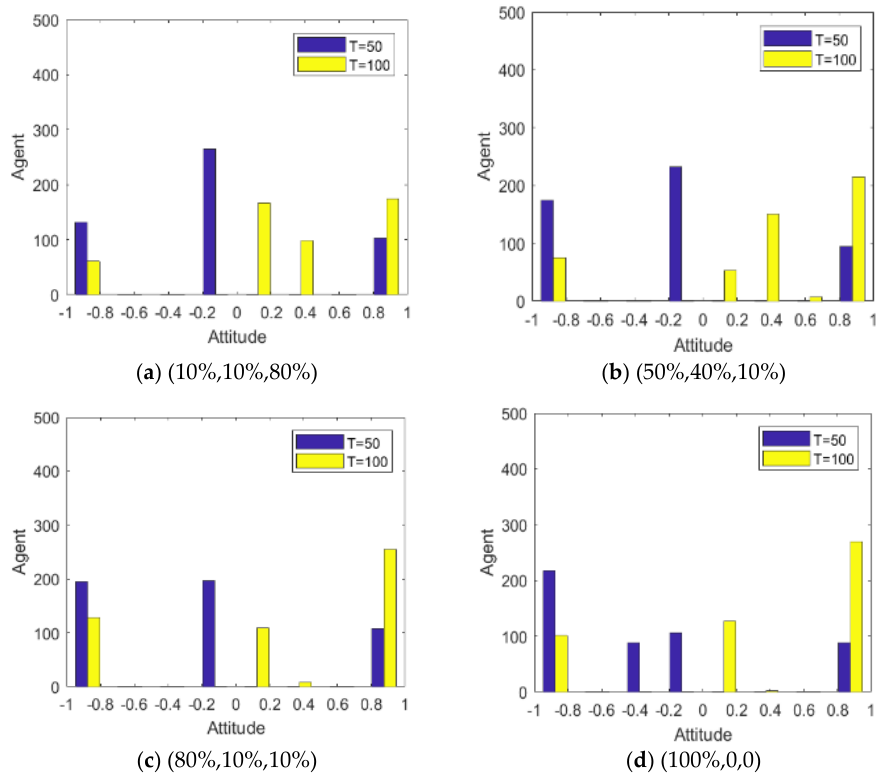
Figure 13. Histogram of the group attitude distribution under different proportion. ( a ) (10%,10%,80%); ( b ) (50%,40%,10%); ( c ) (80%,10%,10%); ( d ) (100%,0,0).